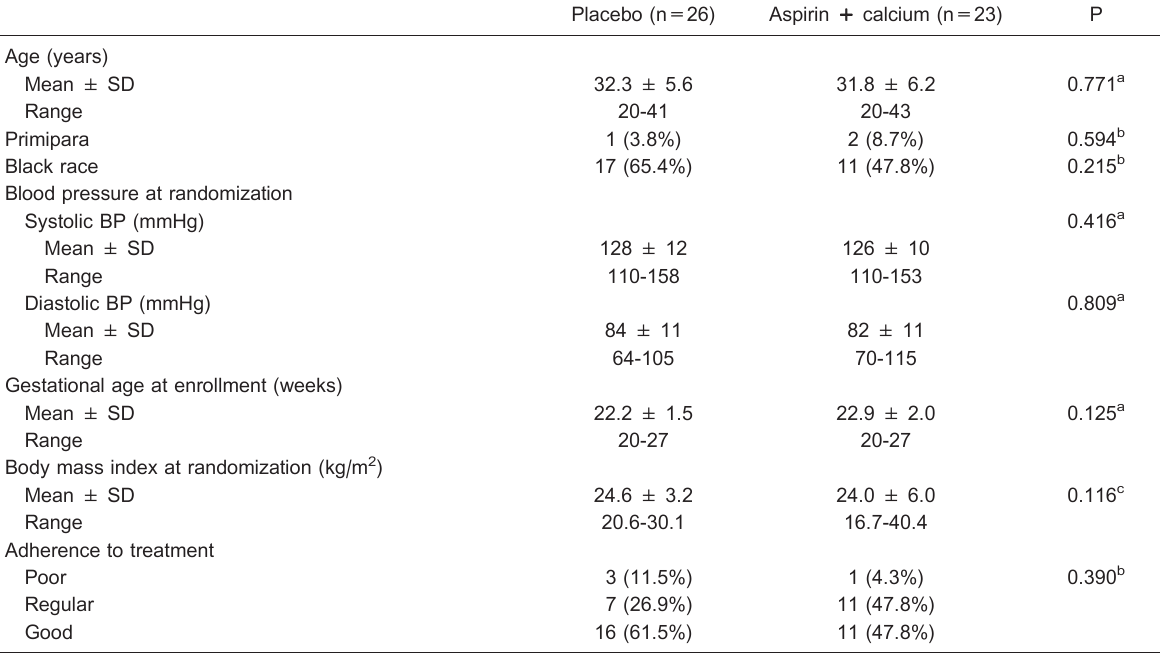
Placebo (n=26) Aspirin ++ calcium (n=23)